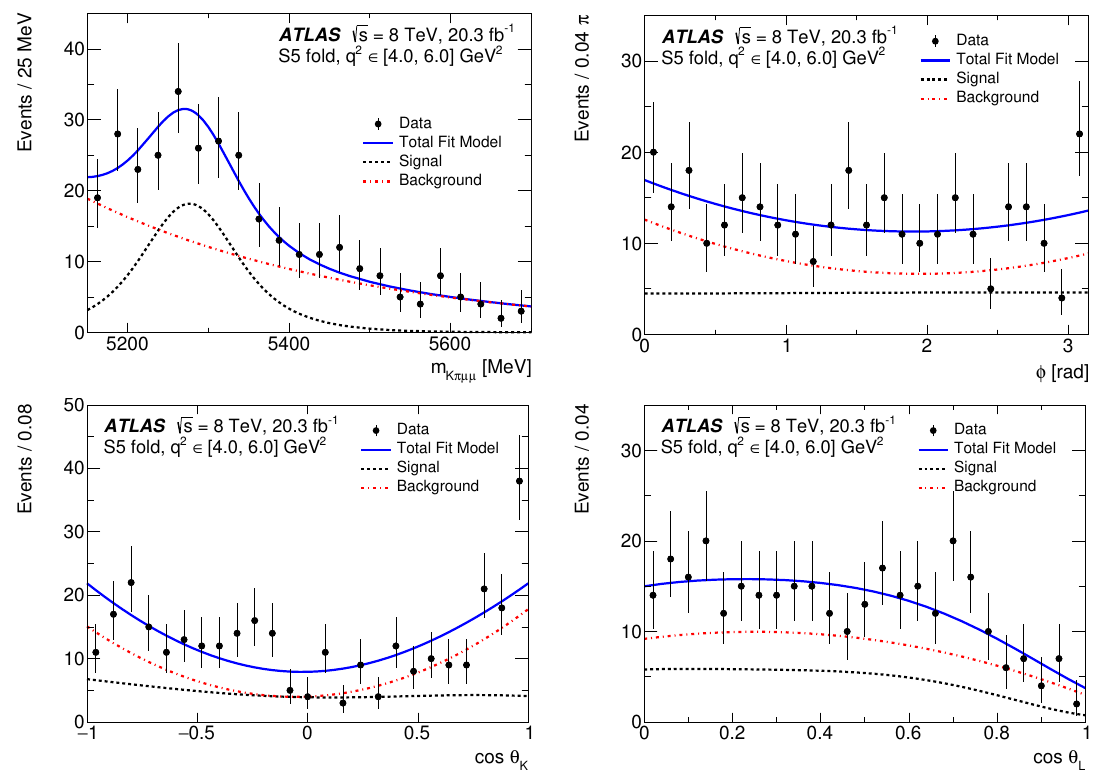
Figure 6 . The distributions of (top left) m , (top right) (cid:30) , (bottom left) cos (cid:18) , and (bottom K(cid:25)(cid:22)(cid:22) K right) cos (cid:18) obtained for q 2 2 [4 : 0 ; 6 : 0] GeV 2 . The (blue) solid line is a projection of the total pdf, L the (red) dot-dashed line represents the background, and the (black) dashed line represents the signal component. These plots are obtained from a (cid:12)t using the S folding 5